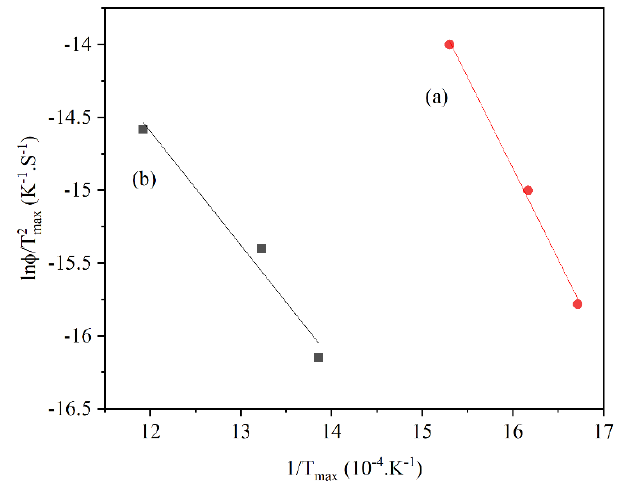
Figure 18. Temperature-programmed Arrhenius plots for the two-step reduction. ( a ) Fe 2 O 3 → Fe 3 O 4 , ( b ) Fe 3 O 4 → Fe [60] “modified”.